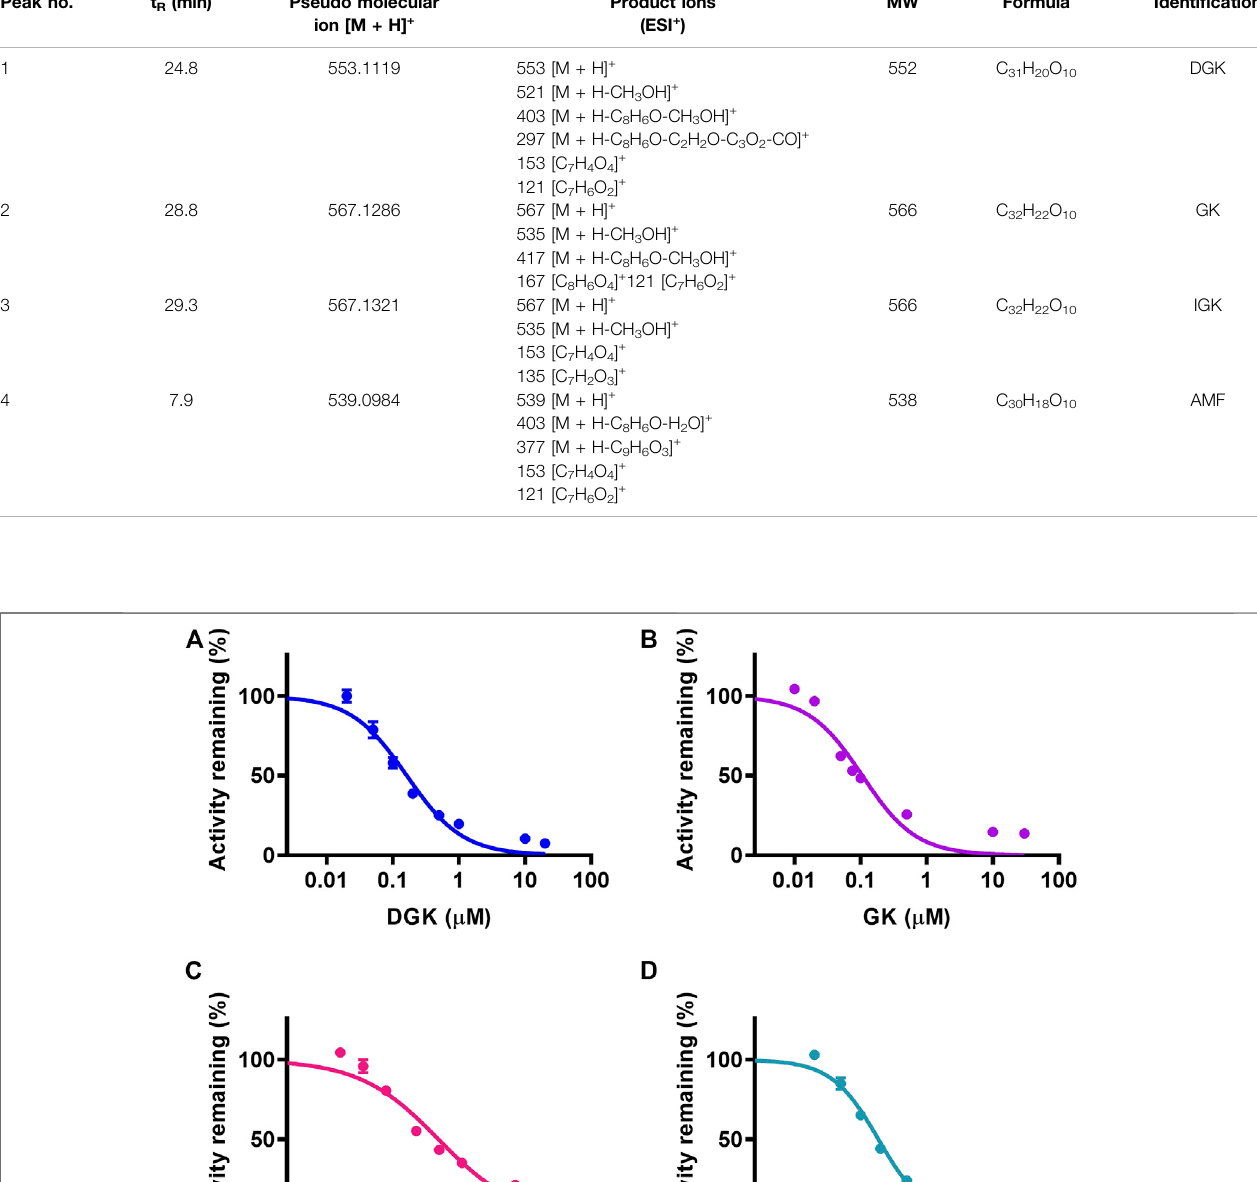
The Inhibitory Effects of Bi fl avones Against the Metabolism of Clinical Drugs The CYP3A4-mediated potential interactions between DGK, GK, IGK, AMF, and clinical drugs were investigated. The selective